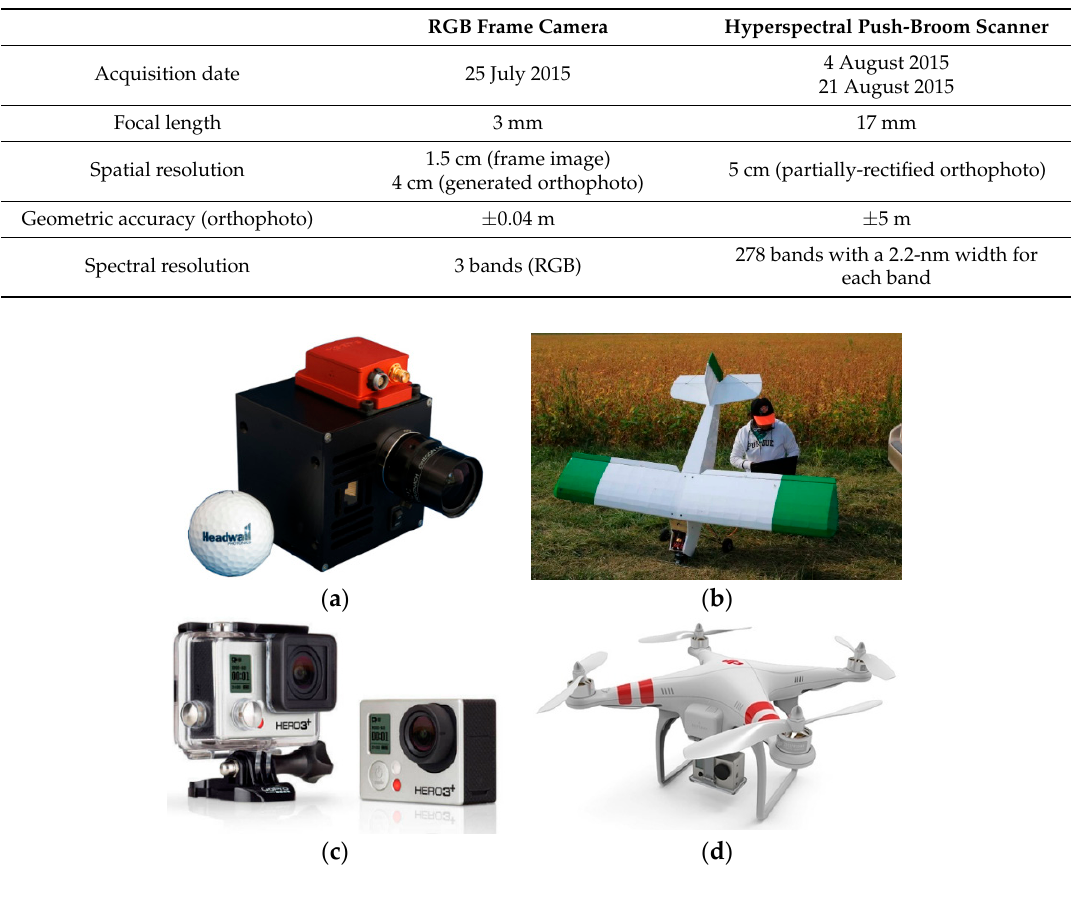
Figure 8. Sensors and UAVs utilized for dataset acquisition: ( a ) hyperspectral push-broom scanner mounted on ( b ) a fixed-wing UAV and ( c ) RGB frame camera mounted on ( d ) a quad copter UAV.